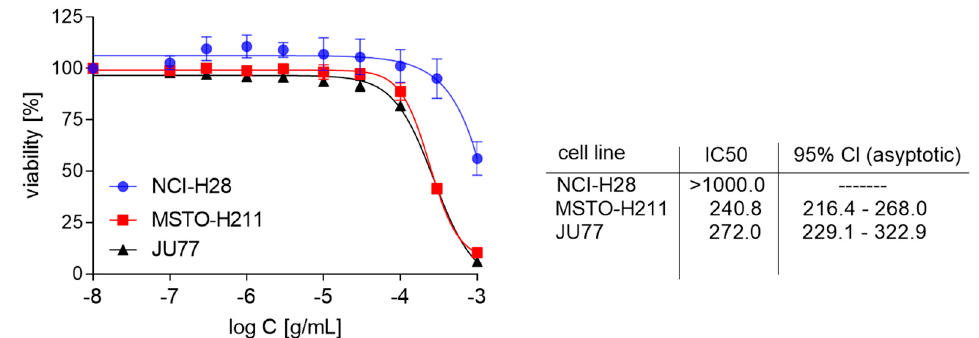
Figure 2. Determination of the growth inhibition by EPE. The data are presented as a percentage of the controls, the IC50 values were calculated using a four-parameter nonlinear logistic regression. Confidence intervals are shown as asymmetrical, due to the log transformation of the data required to perform IC50 calculations. Data are the means of three independent experiments ± SD, IC50 values are shown in µg/mL.